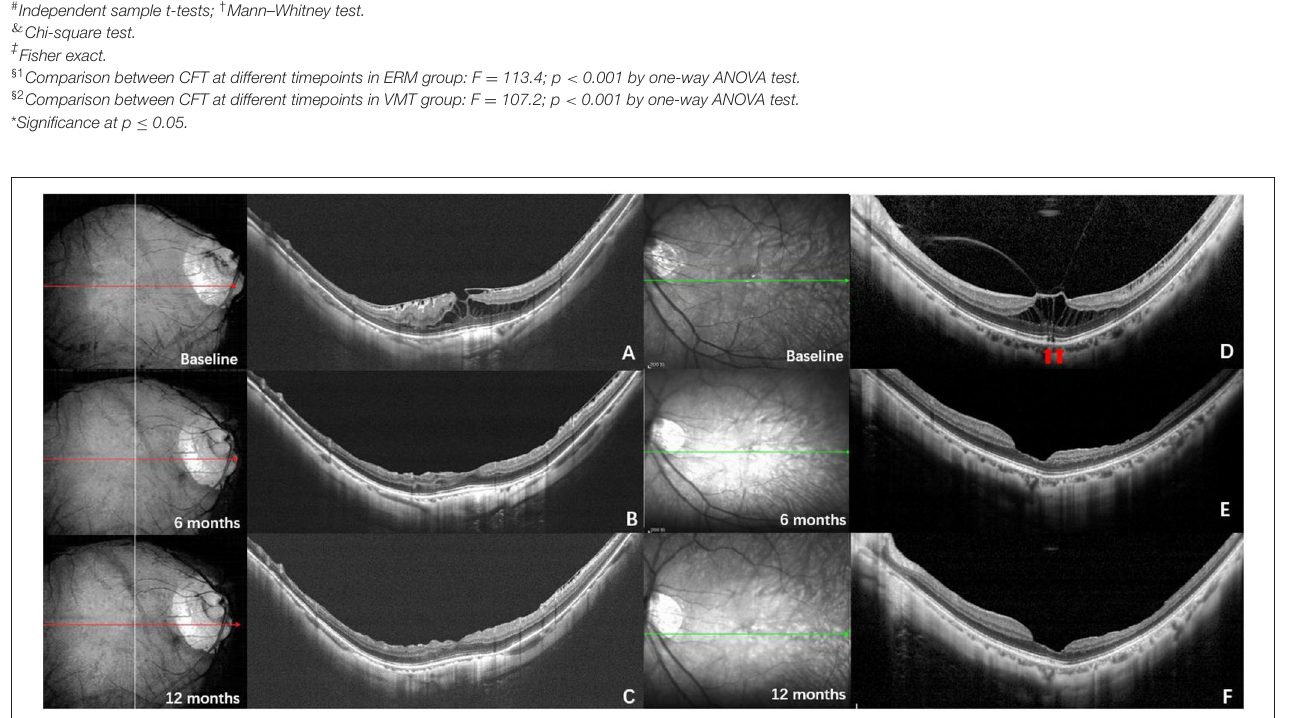
FIGURE 3 | Typical surgical cases. (Left) OCT images of a 51-year-old man. (A) The OCT at baseline shows foveoschisis with the traction of epiretinal membrane (ERM). The axial length was 29.75mm, and the baseline Logmar best corrected visual acuity (BCVA) was 0.3; (B) six months after vitrectomy, internal limiting membrane and ERM peeling and air tamponade, most of the retinoschisis resolved apart from the perifovea; (C) twelve months after surgery, the retinoschisis completely resolved, the Logmar BCVA was 0.05; (Right) OCT images of a 52-year-old woman. (D) The OCT at baseline shows foveoschisis with vitreoretinal traction (VMT). The ellipsoid zone of the outer retina was disrupted (red arrows). The axial length was 28.10mm, and the baseline Logmar BCVA was 0.7; (E) six months after vitrectomy, internal limiting membrane peeling and air tamponade, the retinoschisis completely resolved, the ellipsoid zone became intact; (F) twelve months after surgery, the fundus remained stable, and the Logmar BCVA was